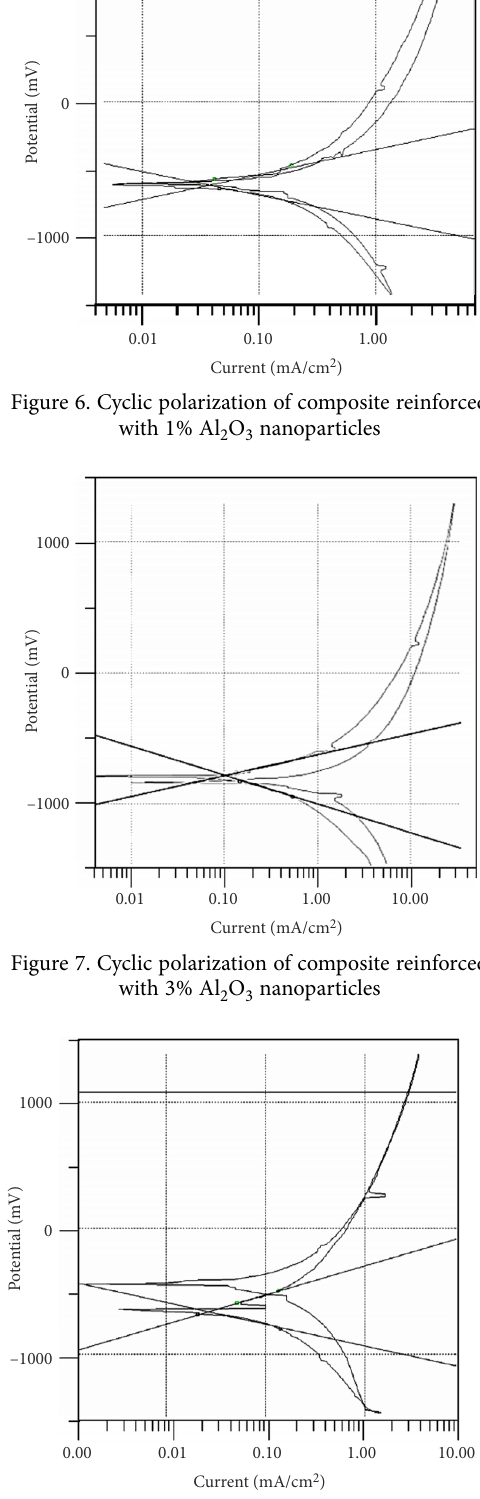
Figure 8. Cyclic polarization of composite